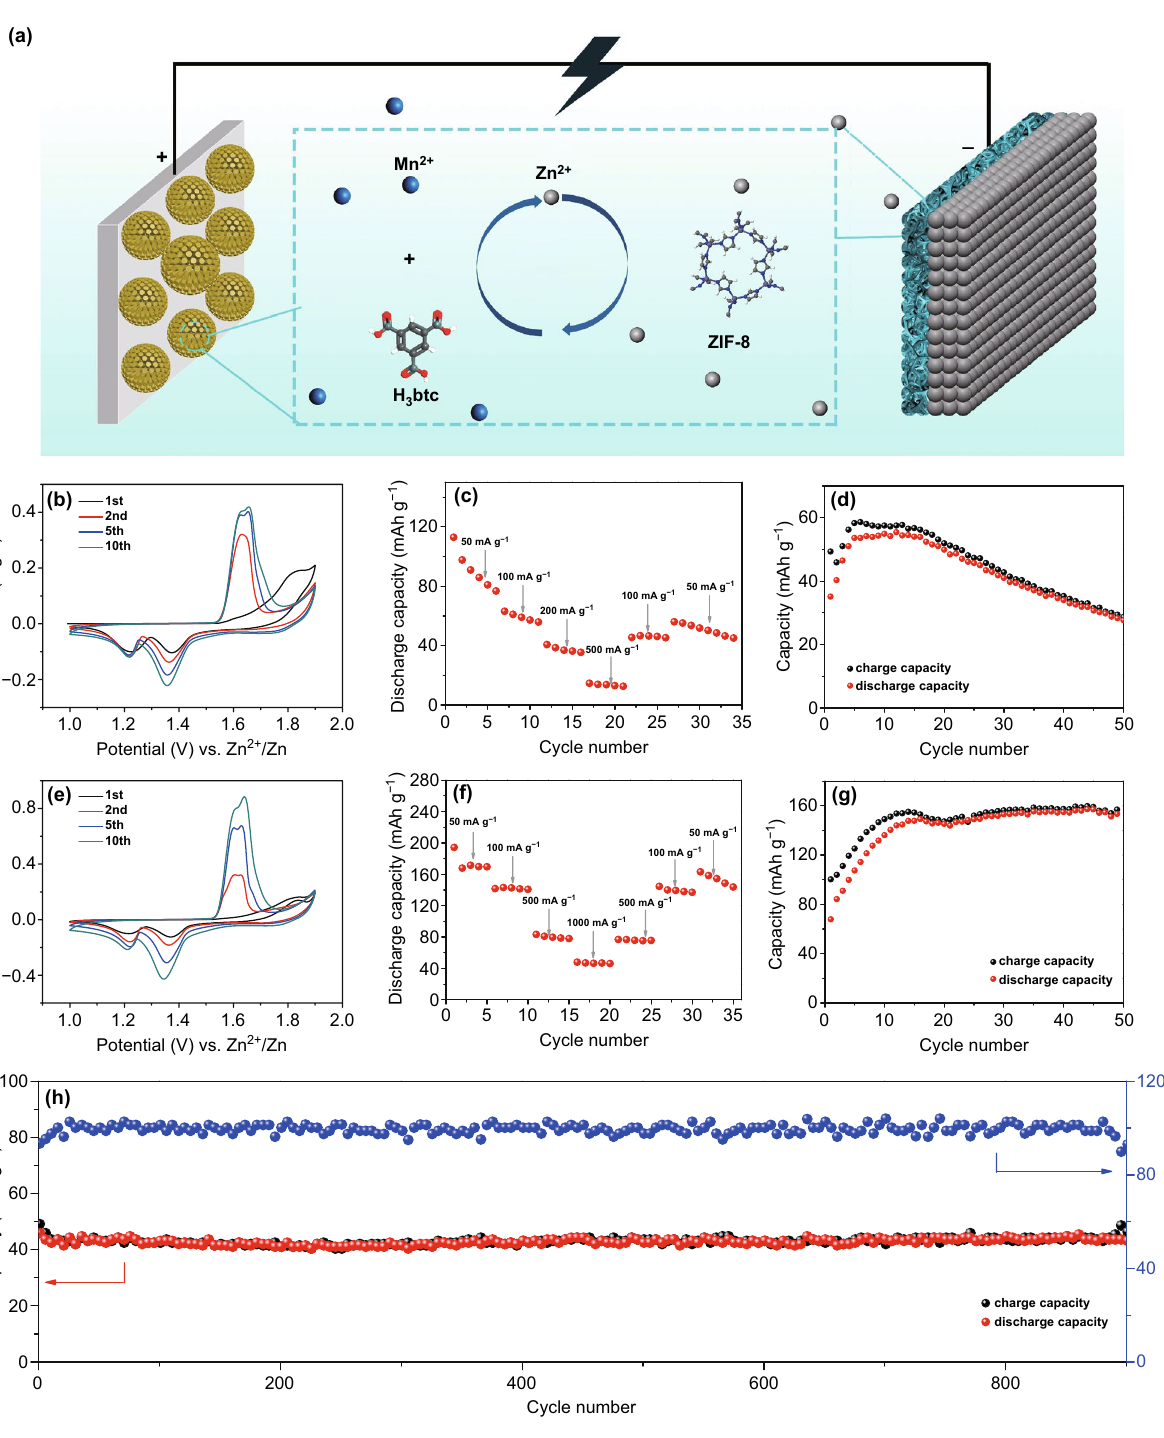
Fig. 7 a Schematic of the Mn(BTC) cathode//ZIF‑8@Zn anode ZIBs. Electrochemical performance of the ZIBs: b CV curves at 0.5 mV s −1 , c rate capability, and d cycling performance at 100 mA g −1 in 2 M ZnSO 4 electrolyte; e CV curves at 0.5 mV s −1 , f rate capability and cycling per‑ formance at g at 100 mA g −1 , and h at 1000 mA g −1 in 2 M ZnSO 4 + 0.1 M MnSO 4